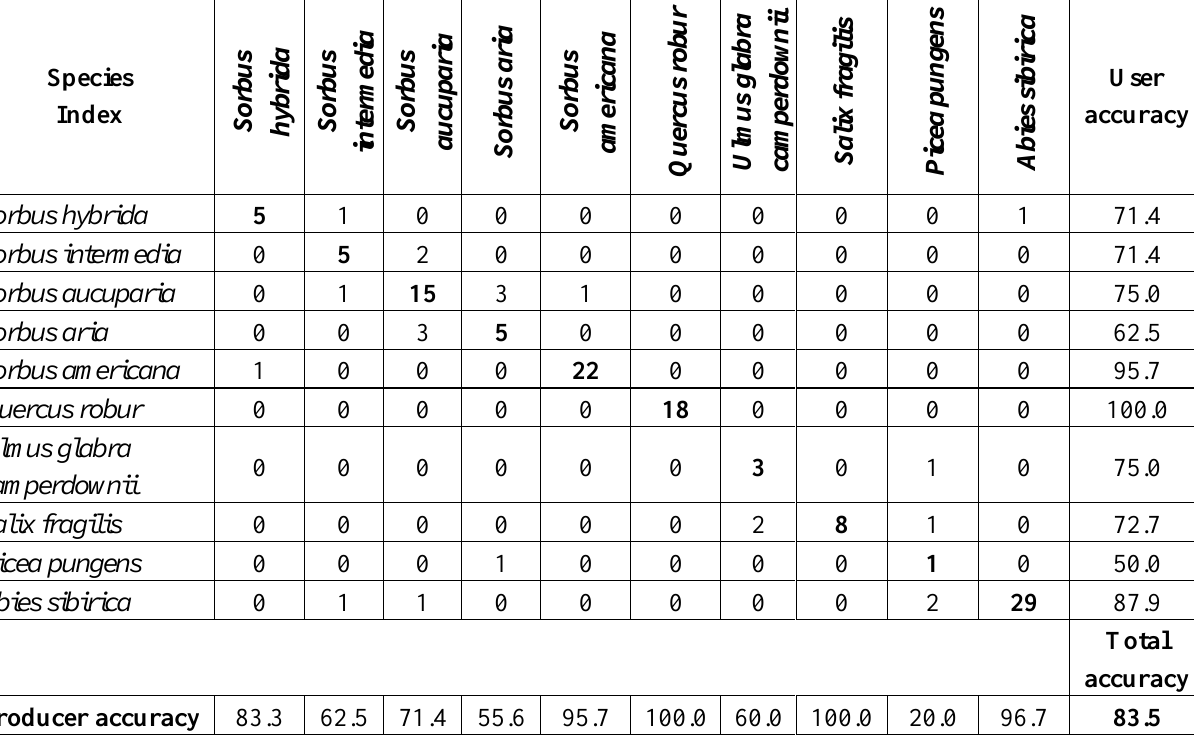
Table 5. The error matrix of the species-wise classification result of the best selected feature quadruple (LiDAR-derived features were the 90% height quantile (hq90)andthe mean height of a single tree specimen, and hyperspectral features that were the channels centered at 428 nm and at 982 nm). Bolded numbers in the diagonal are the numbers of correctly classified tree specimens. All classification accuracies are given in